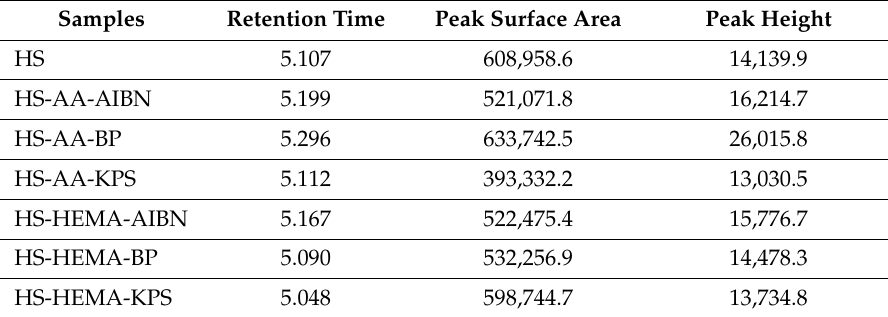
Table 4. Individual parameters of chromatograms for copolymer samples.